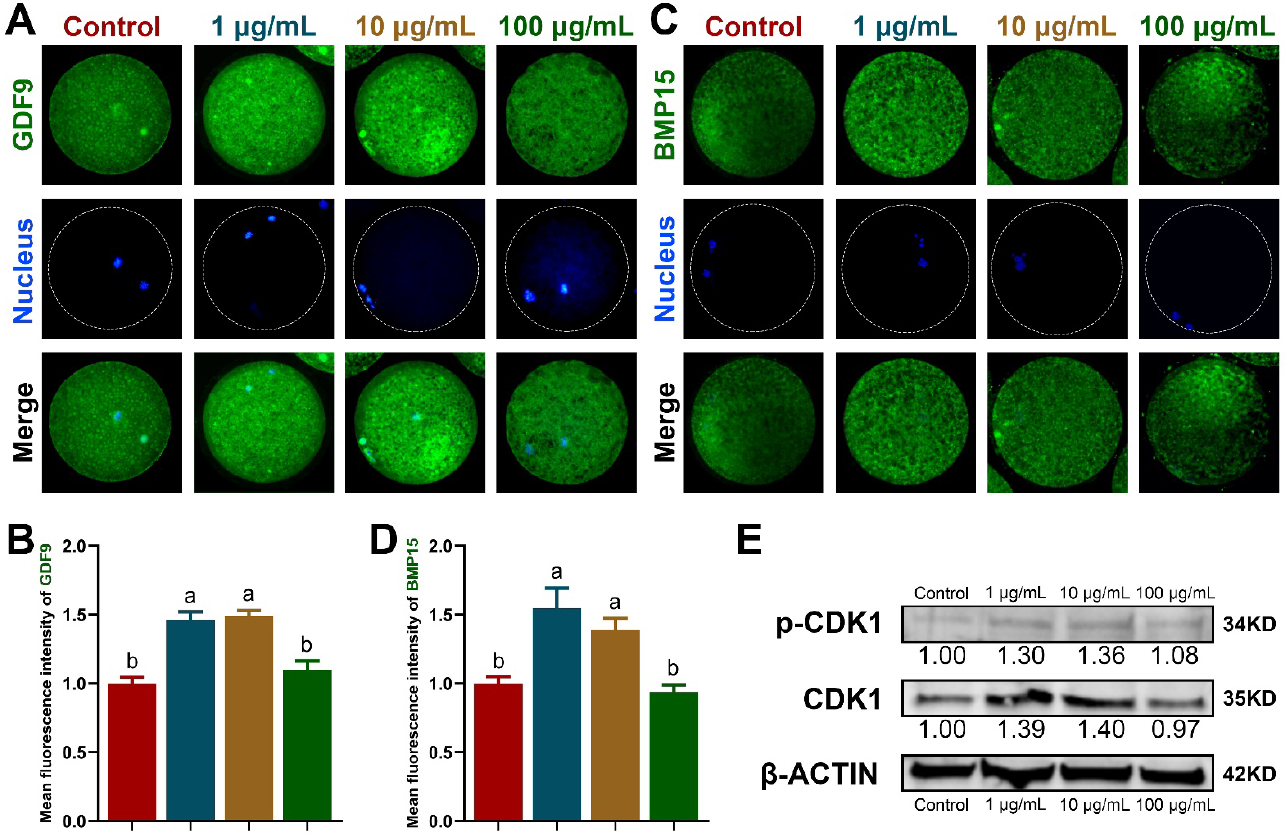
Figure 1. Detection of GDF9 and BMP15 proteins by immunofluorescence staining and detection of p-CKD1 and CKD1 proteins by Western blot in oocytes. ( A , B ) GDF9 protein expression. ( C , D ) BMP15 protein expression. ( E ) p-CDK1 and CDK1 protein expression. Within the same indicator, bars with different letters indicate a significant difference ( p < 0.05). Results are shown as the average ± SEM of at least three repeats of independent experiments. A total of 30 oocytes were analyzed per group in each replicate.